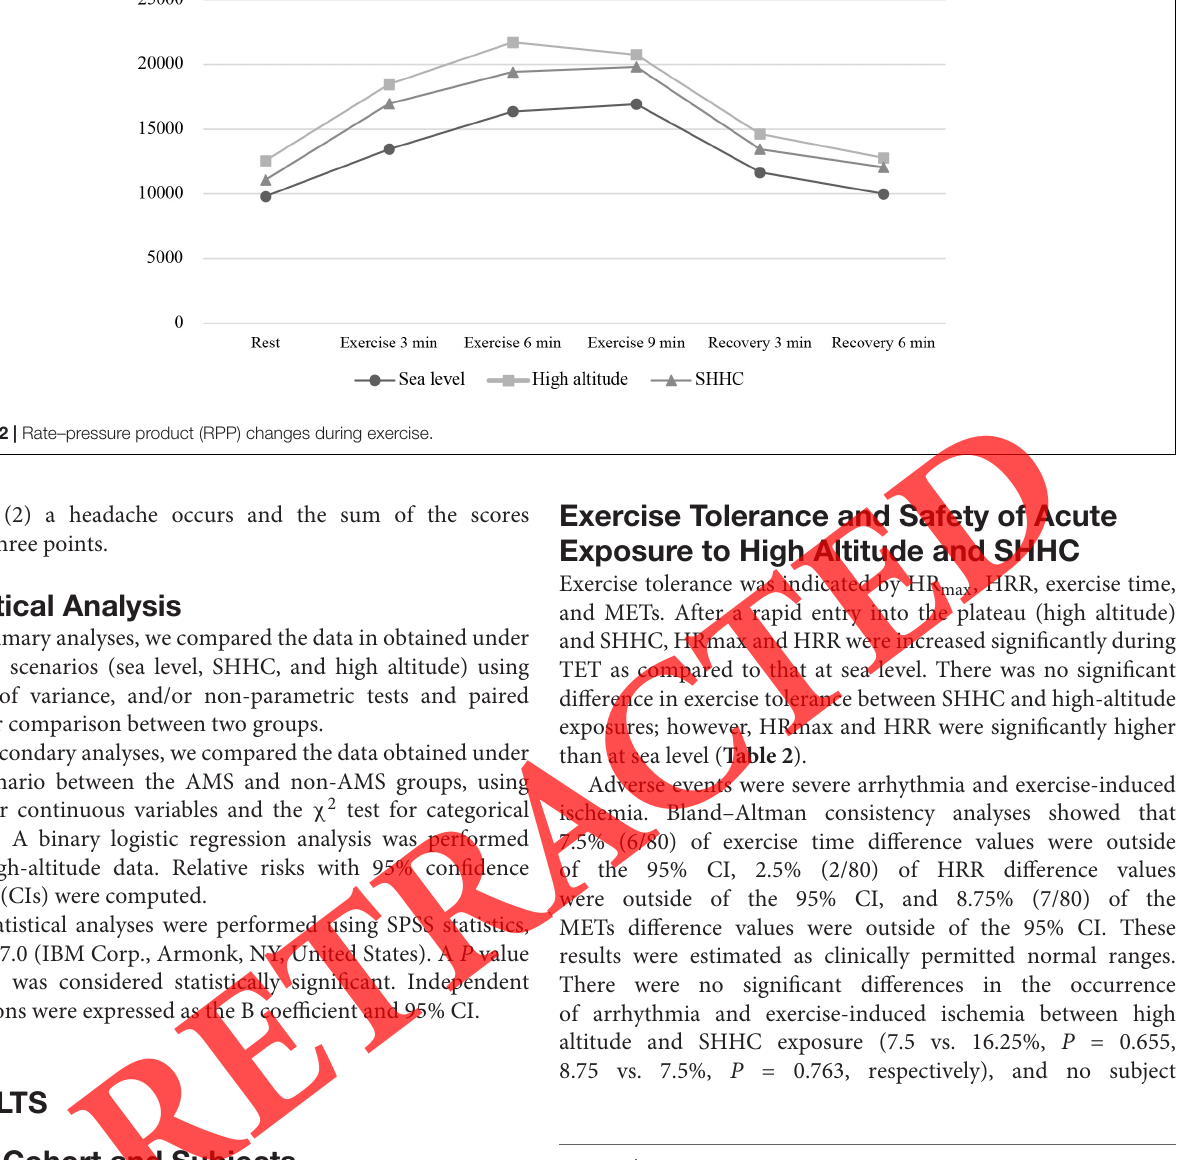
TABLE 2 | Comparison of exercise tolerance in three